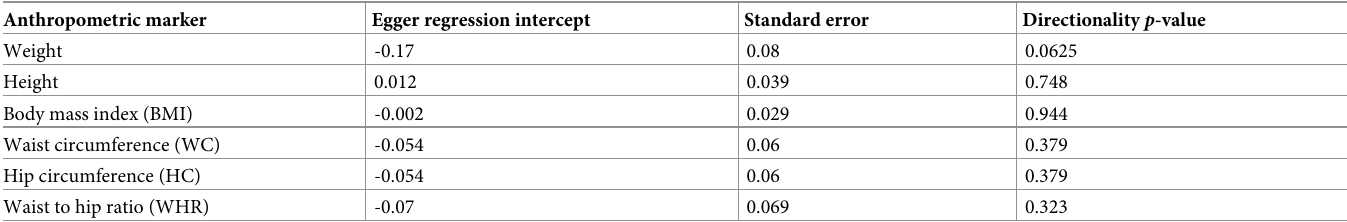
Table 4. Horizontal pleiotropy statistics of two-sample Mendelian randomization analyses.